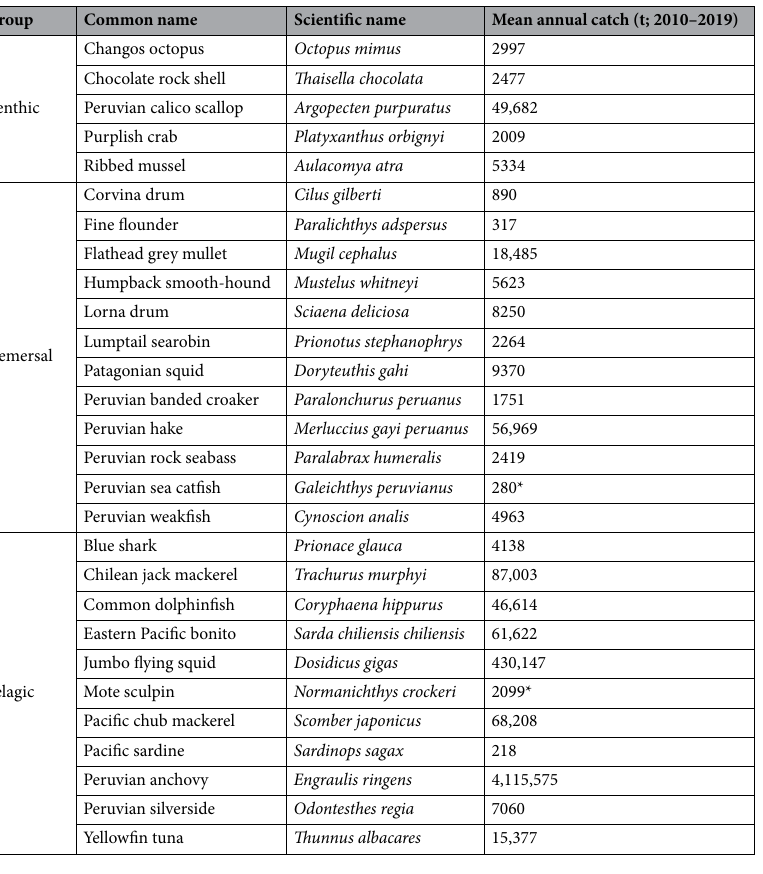
Table 1. Key fishery resources in the Northern Humboldt Current System examined in the vulnerability assessment to climate change. *Commercial catch data only available from